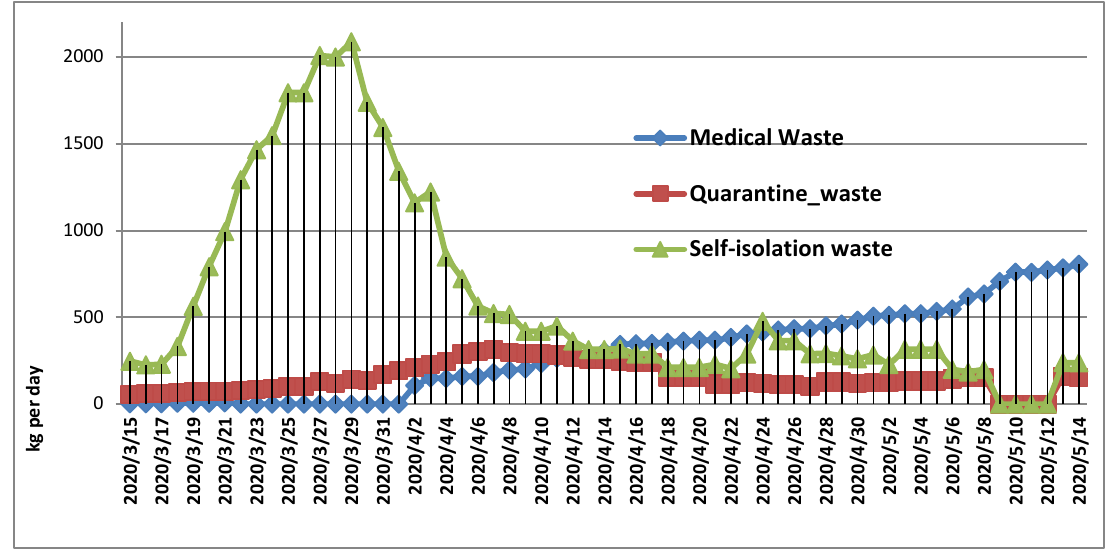
Figure 4. COVID-19 related waste flow in Neamt County during the emergency state.